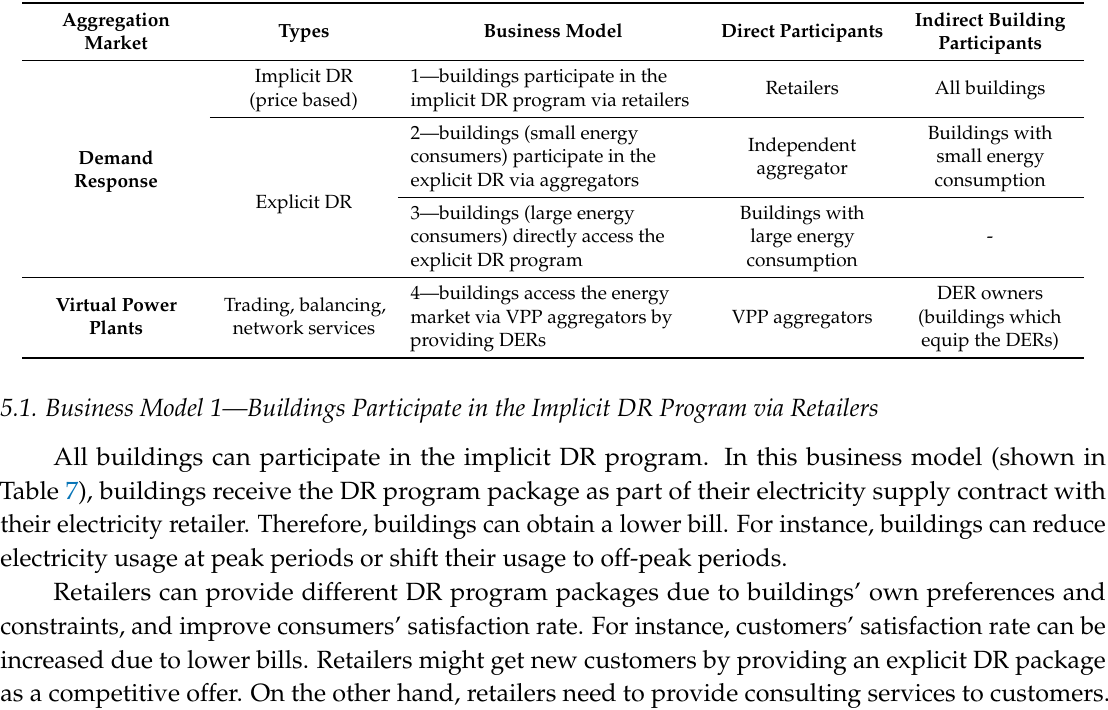
Table 6. Four Business Models of Buildings’ Participation in the Aggregation